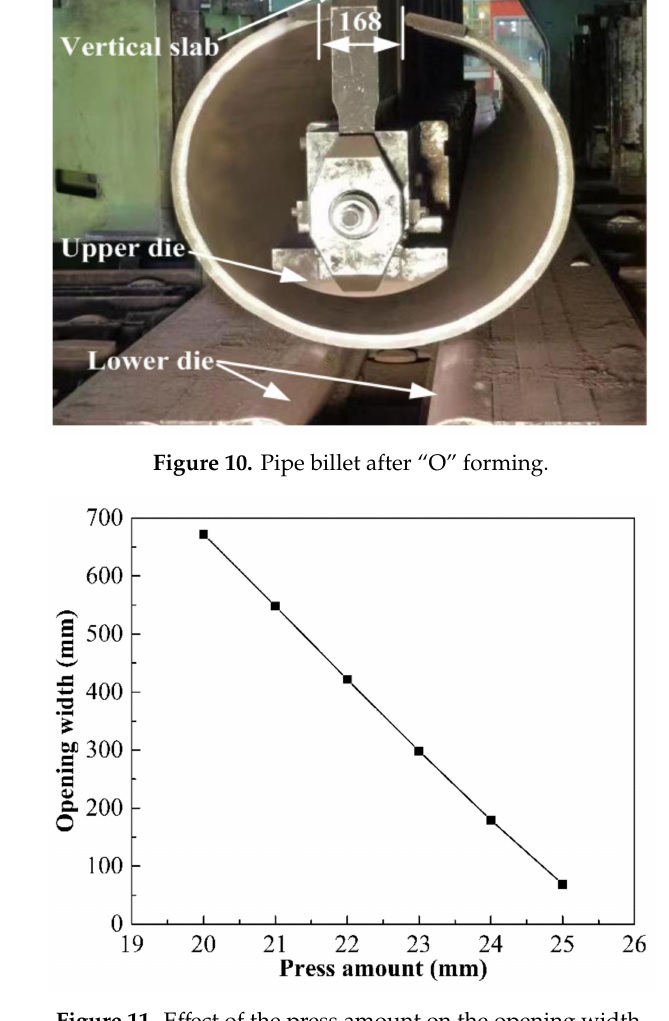
Figure 11. E ff ect of the press amount on the opening